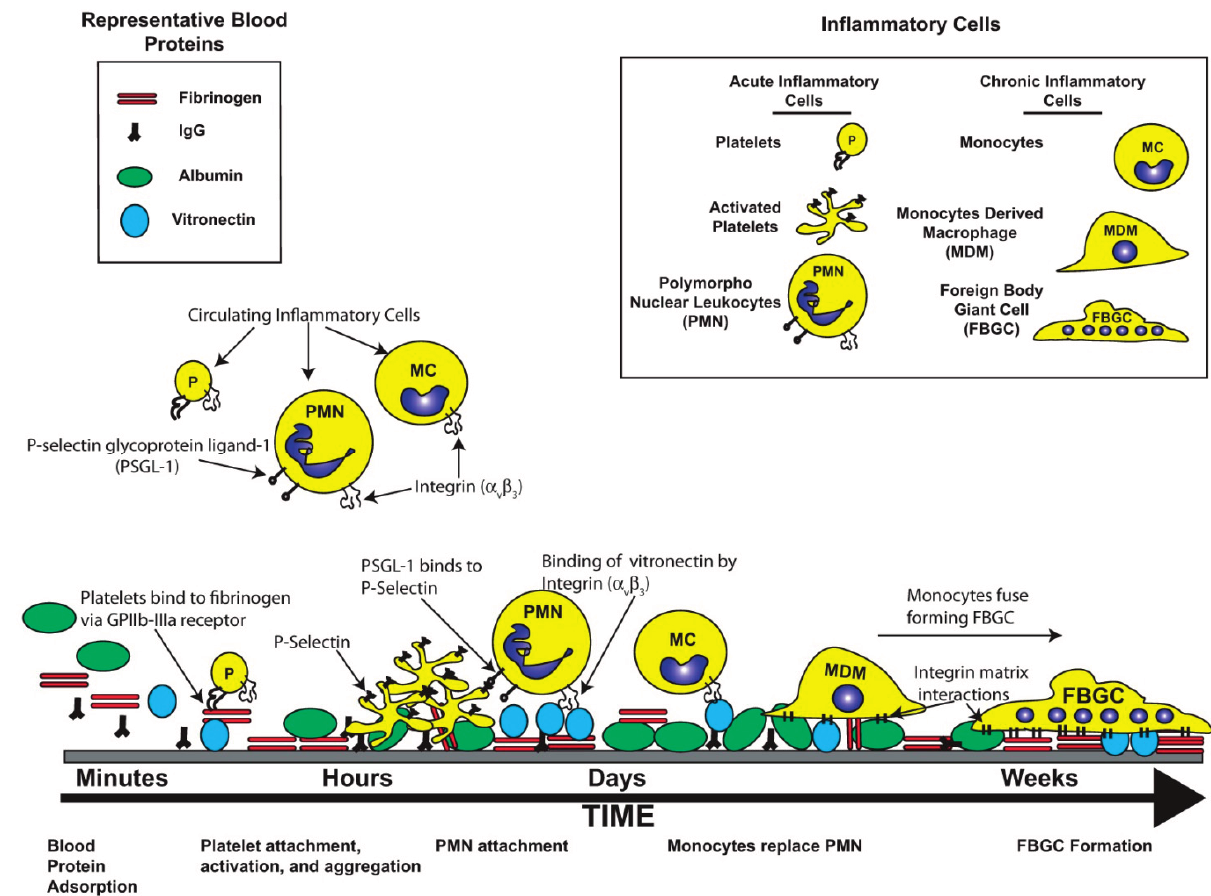
Figure 1. The Host Inflammatory Response to Biomaterials. The introduction of the synthetic surfaces, used in biomedical devices, initiates a host inflammatory response that involves the coordinated recruitment of pro-inflammatory cells and molecules. The initial stage of this process is the adsorption of blood proteins onto the material surface. This provides a high affinity matrix for the subsequent attachment of inflammatory